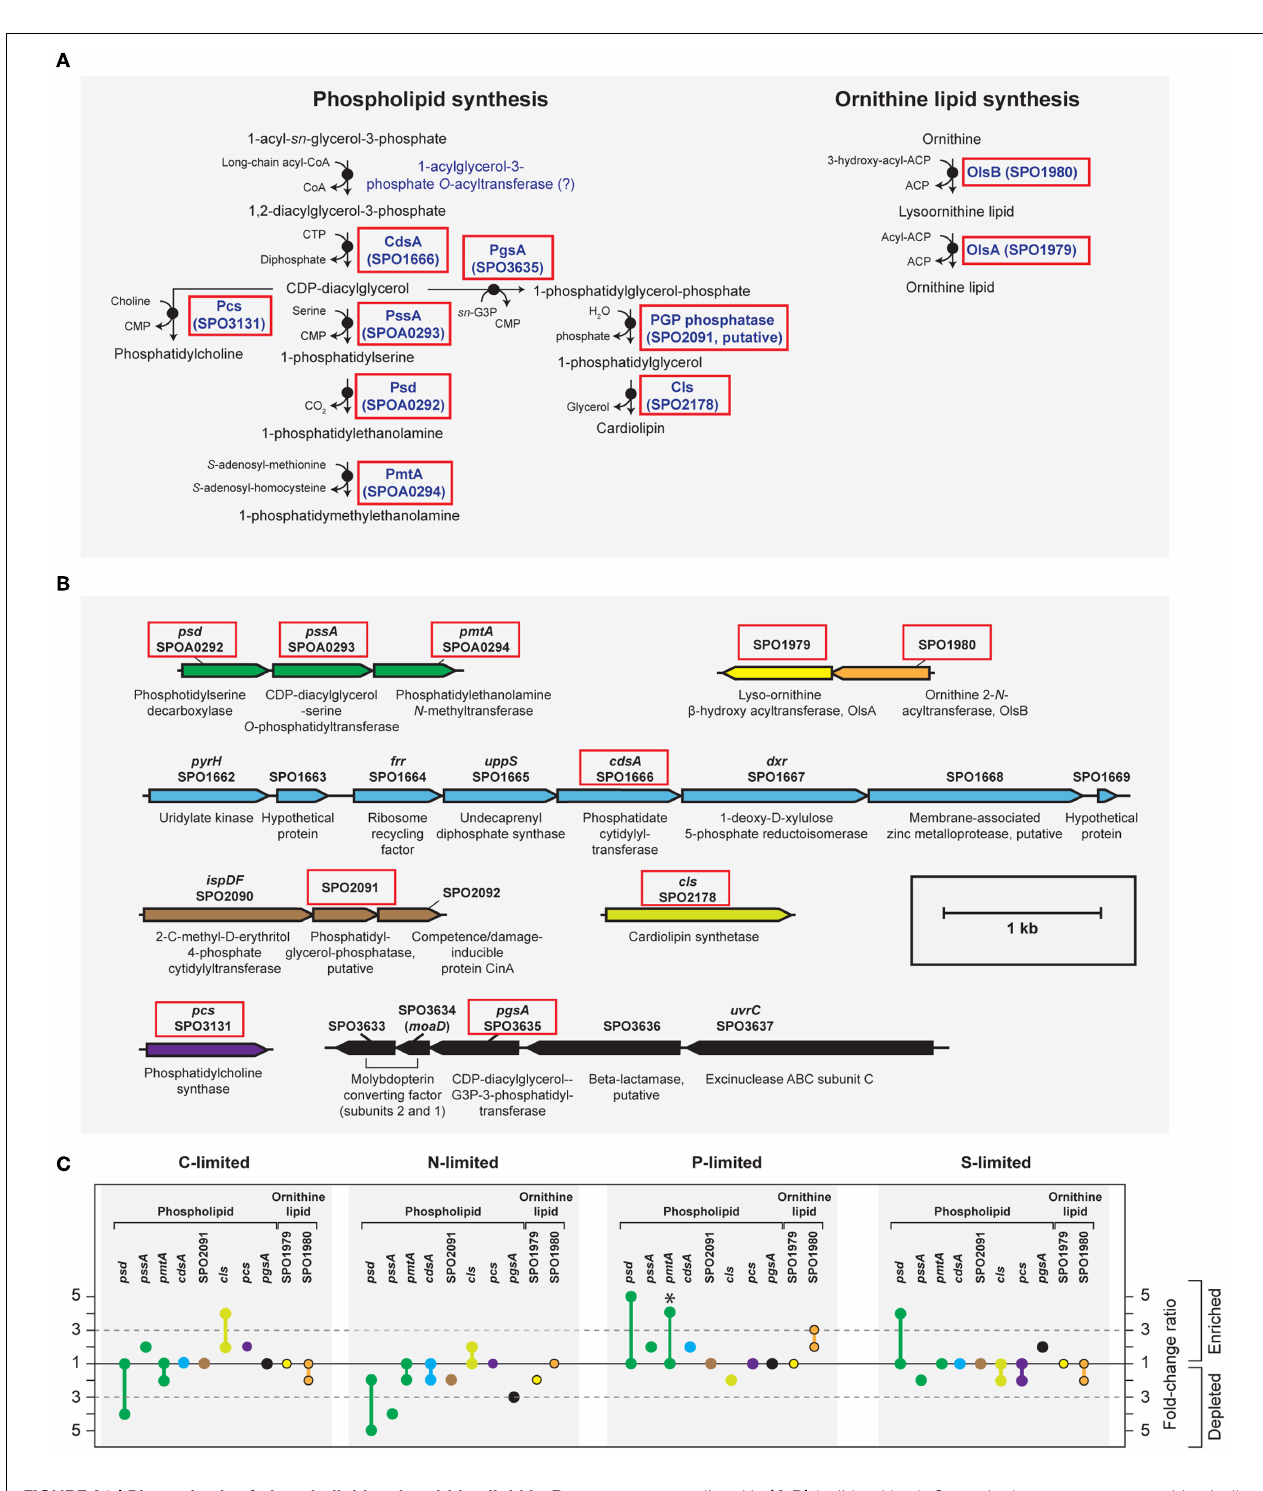
FIGUREA3 | Biosynthesis of phospholipid and ornithine lipid in R. pomeroyi DSS-3. Strain DSS-3 does not encode genes to synthesize other bacterial P-free lipids (betaine lipid, btaAB ; glycolipid/sulfolipid, sqdBCDX ). (A) Pathway inferred from BioCyc; (B) arrangement of lipid synthesis genes on the chromosome; (C) transcription ratios for relevant genes; values shown for